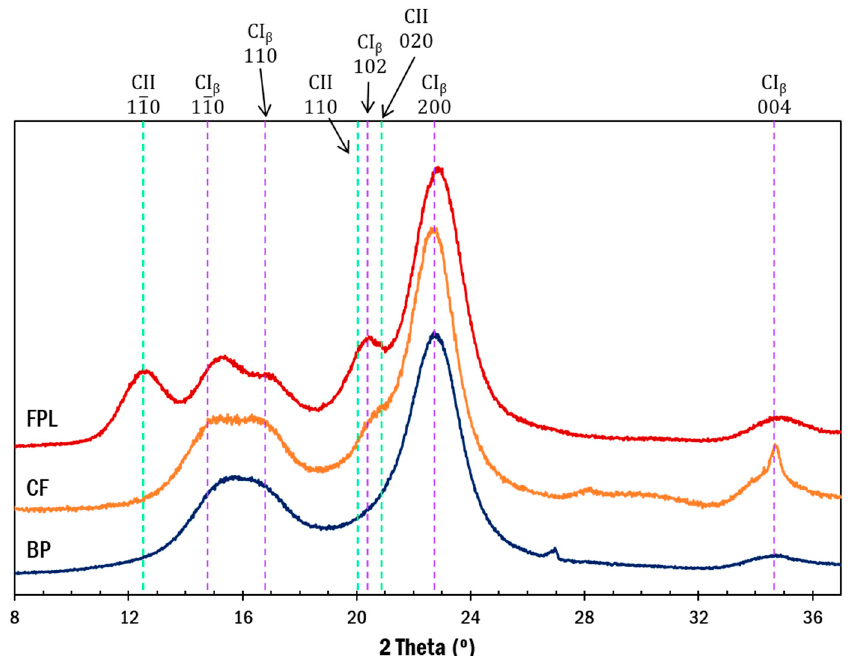
Figure 5. X-ray diffraction (XRD) powder patterns from the three different sources indicating cellulose I β for CF and BP CNCs and cellulose I β and cellulose II for FPL CNCs. Miller indices of the peaks are shown on the graph (CI β = Cellulose I β —purple lines; CII = Cellulose II—green lines).